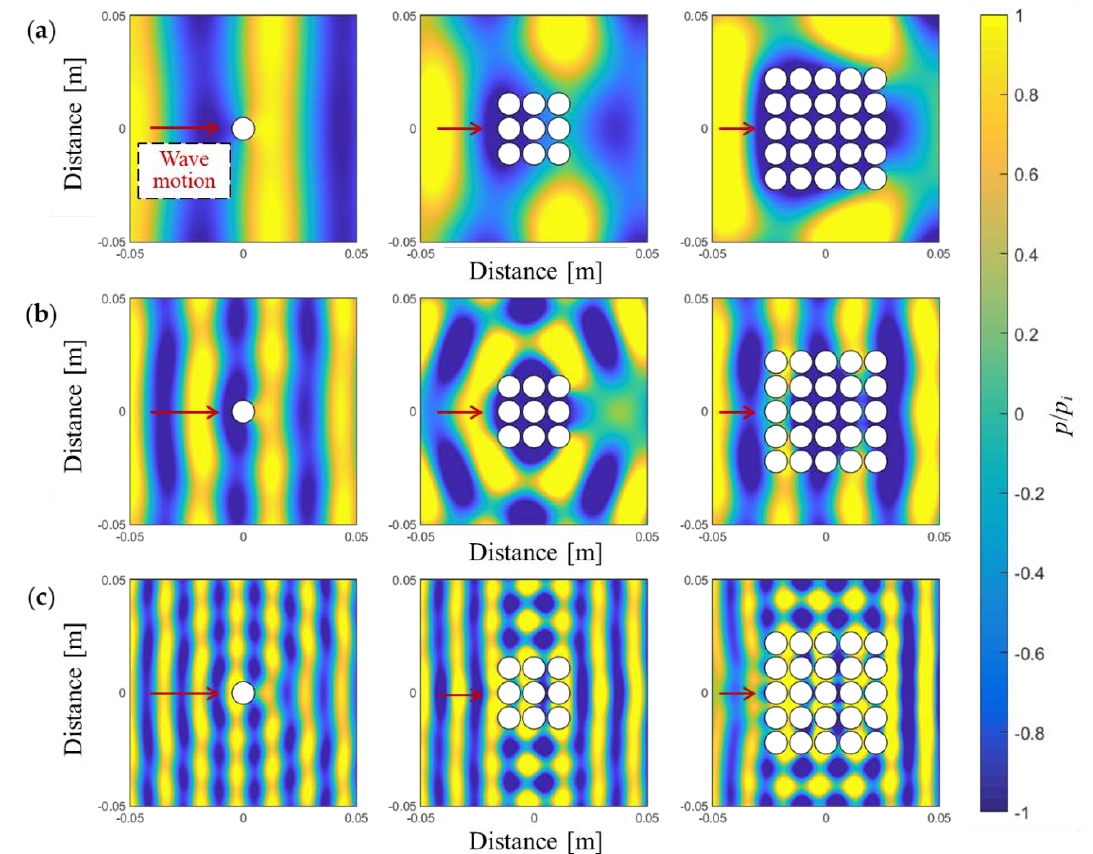
Figure 6. Pressure wave pattern produced by the multiple scattering of the plane wave with a wavelength of ( a ) k f R = 0.5, ( b ) k f R = 1.0, and ( c ) k f R = 2.0. The left, middle, and right sides of the contours represent wave propagation with one, nine, and 25 cylinders.